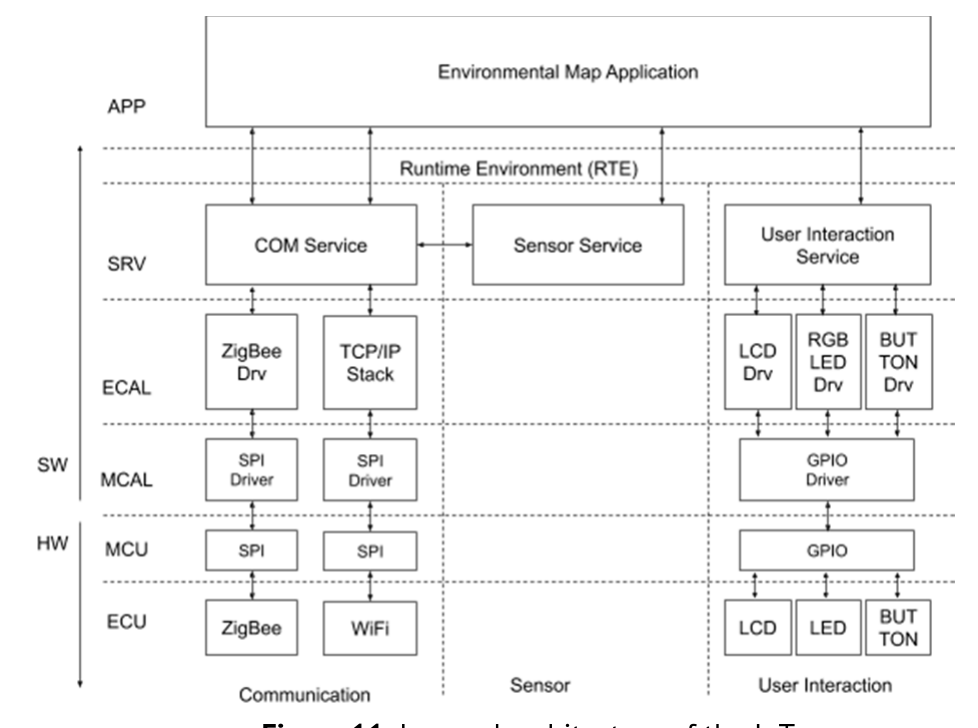
Figure 11. Layered architecture of the IoT